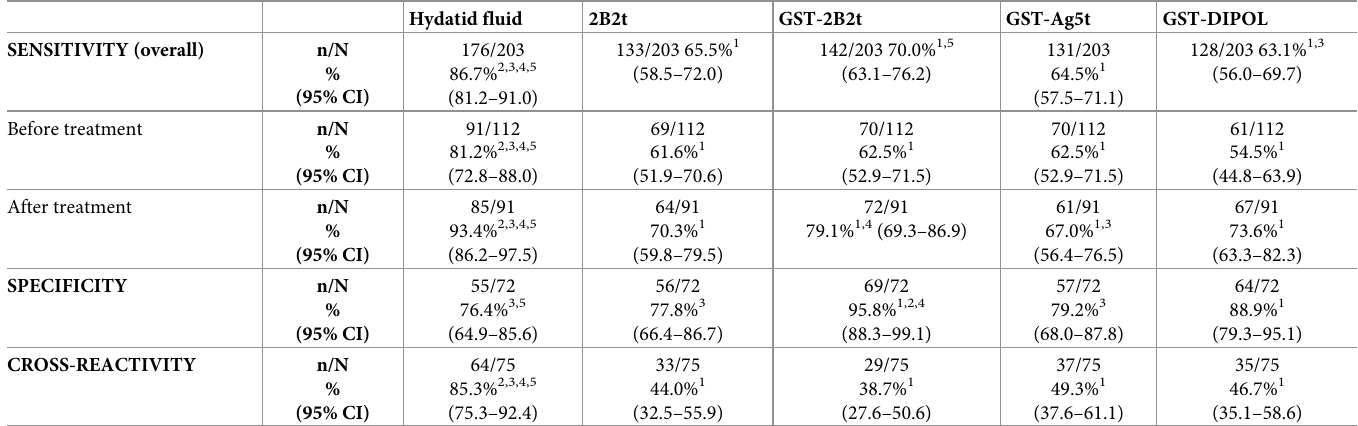
Table 3. Sensitivity, specificity and cross-reactivity of the tests for the detection of IgG in